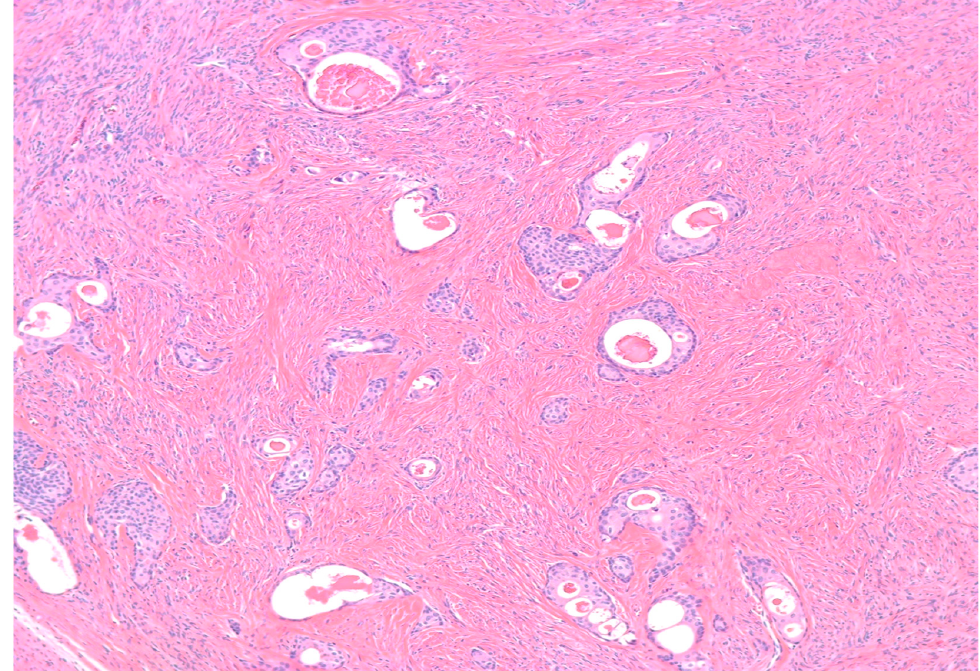
Figure 4. H&E microscopic image of extensive cystic changes involving the epithelial nests of a benign Brenner tumor (100 × magnification).